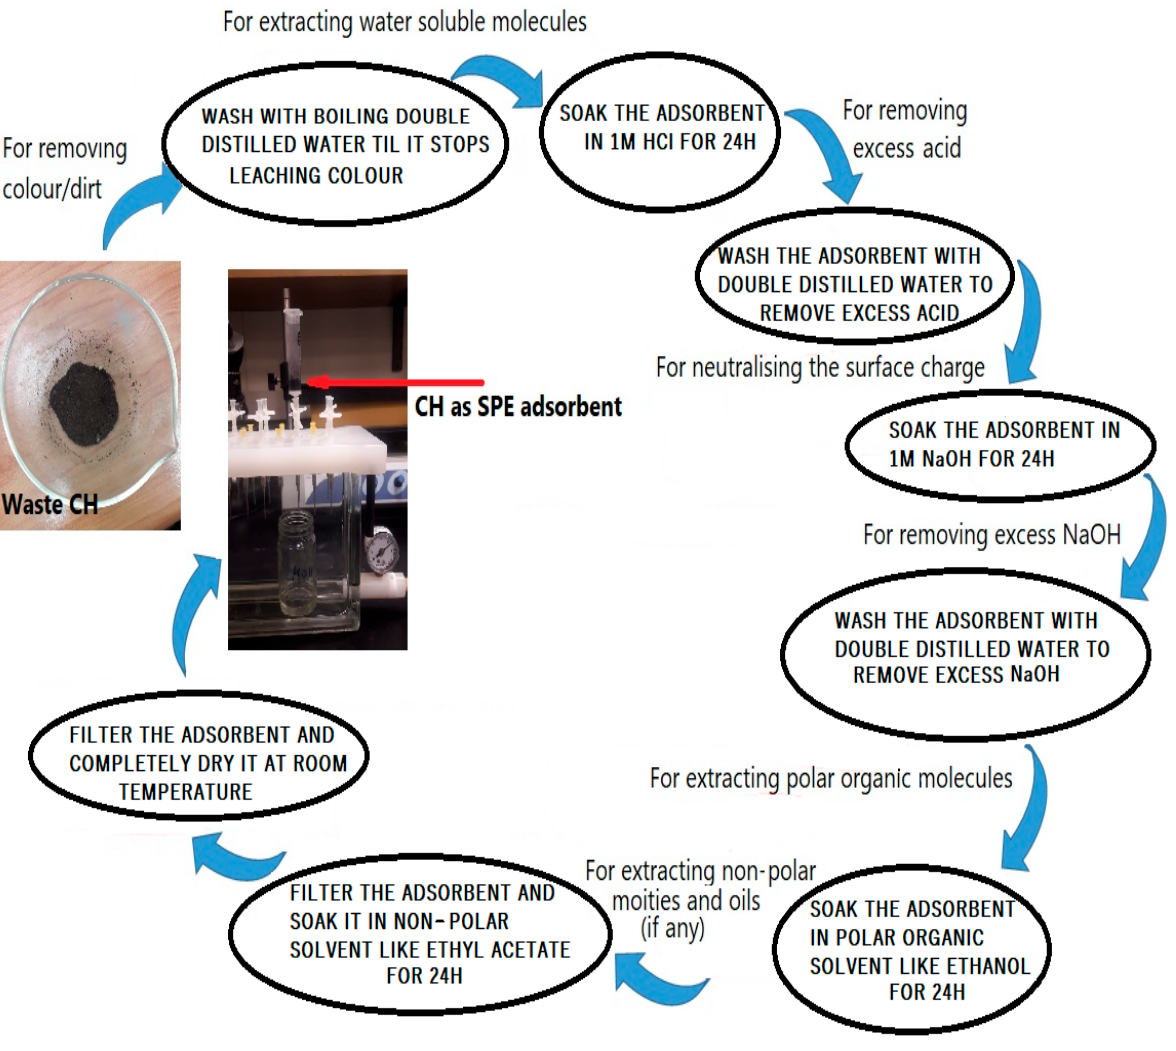
Figure 1. Pictorial representation of the steps for the preparation of the adsorbent.